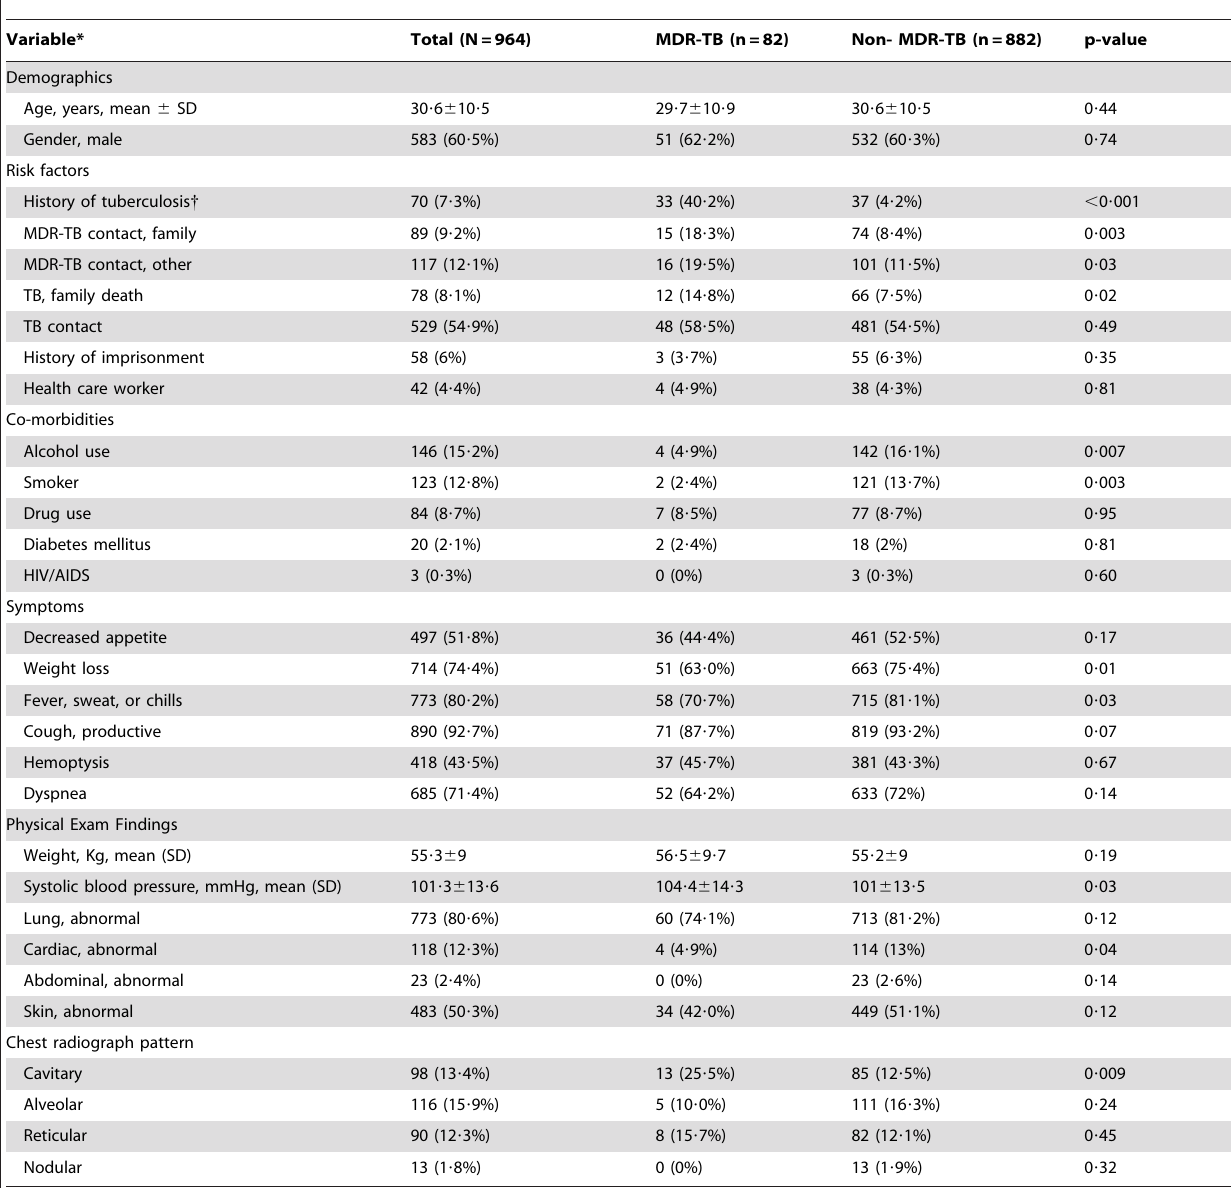
Table 1. Study Population